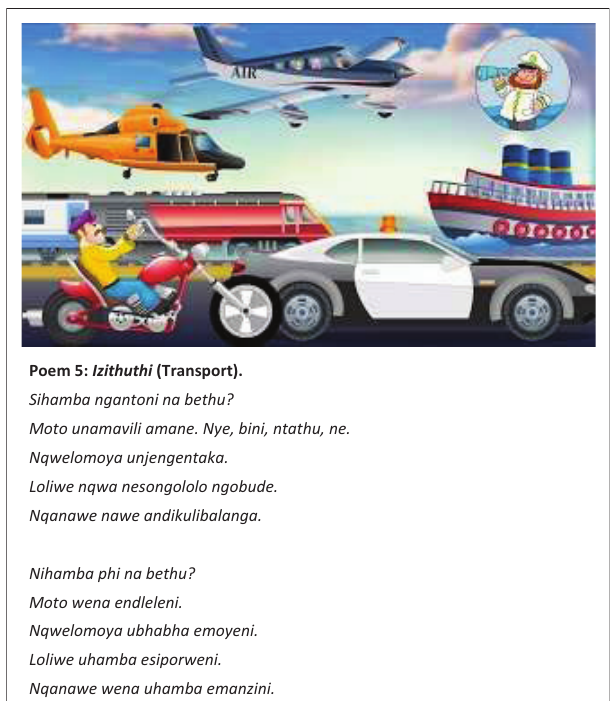
FIGURE 5: Different modes of